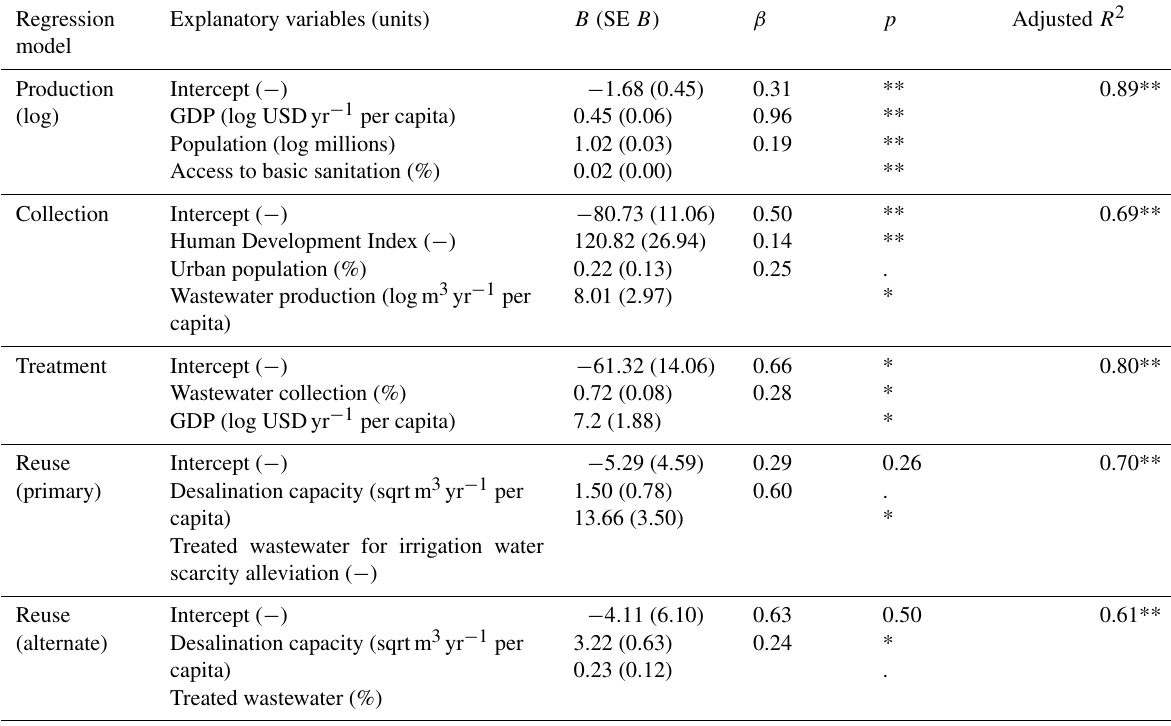
Table 3. Wastewater production, collection, treatment and reuse multiple linear regression